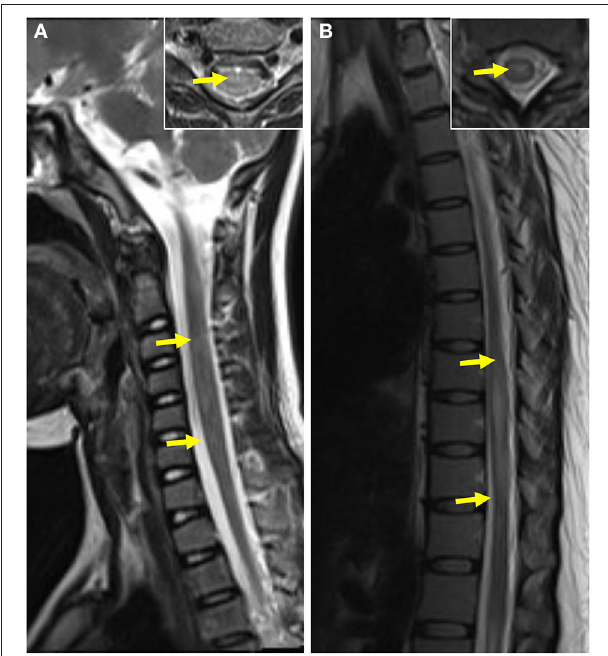
FIGURE 5 | Spinal cord MRI of pediatric and adult patients. (A) T2-weighted MRI of the spinal cord of a pediatric patient showed abnormal patchy signals at the cervical segment The coronal image of lesion-involved slices was showed in the right box. (B) T2-weighted MRI of the spinal cord of an adult patient showed a striped hyperintense lesion at the thoracic segment. The coronal image of lesion-involved slices was showed in the right box.